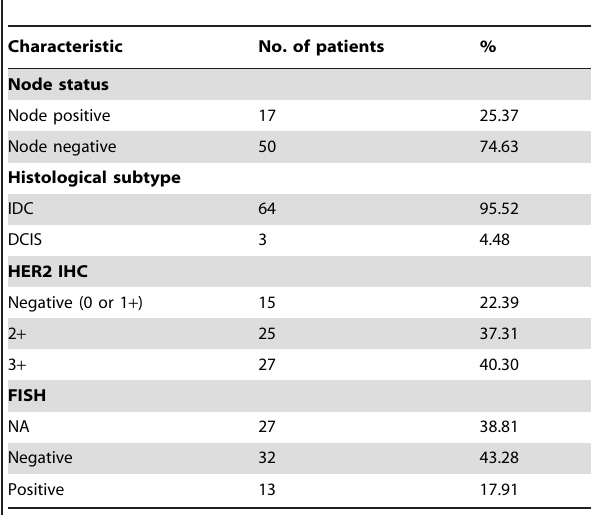
Table 2. Frequencies of clinicalpathological characteristics of 67 patients diagnosed with Breast